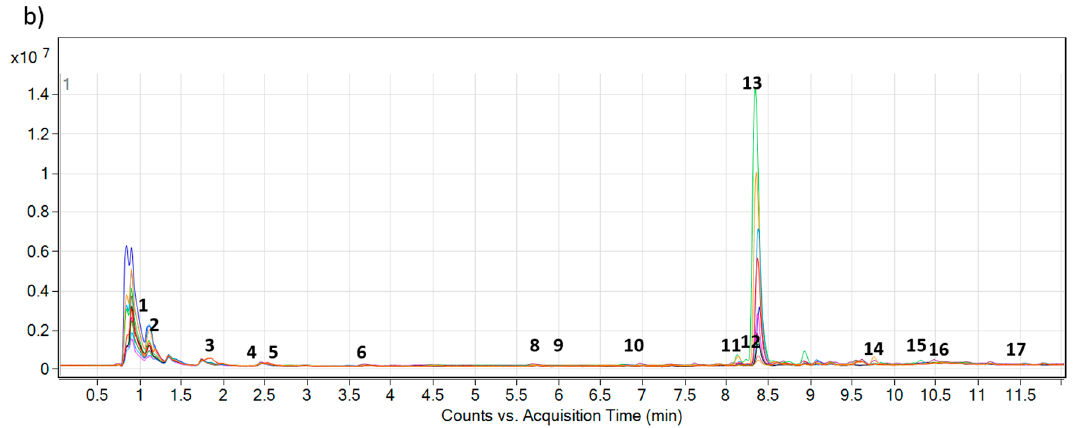
Figure 2. Overlaid total ion chromatograms (TIC) of 12 composite extracts (each represented by different color) of ( a ) Echium plantagineum and ( b ) E. vulgare , grown under identical controlled